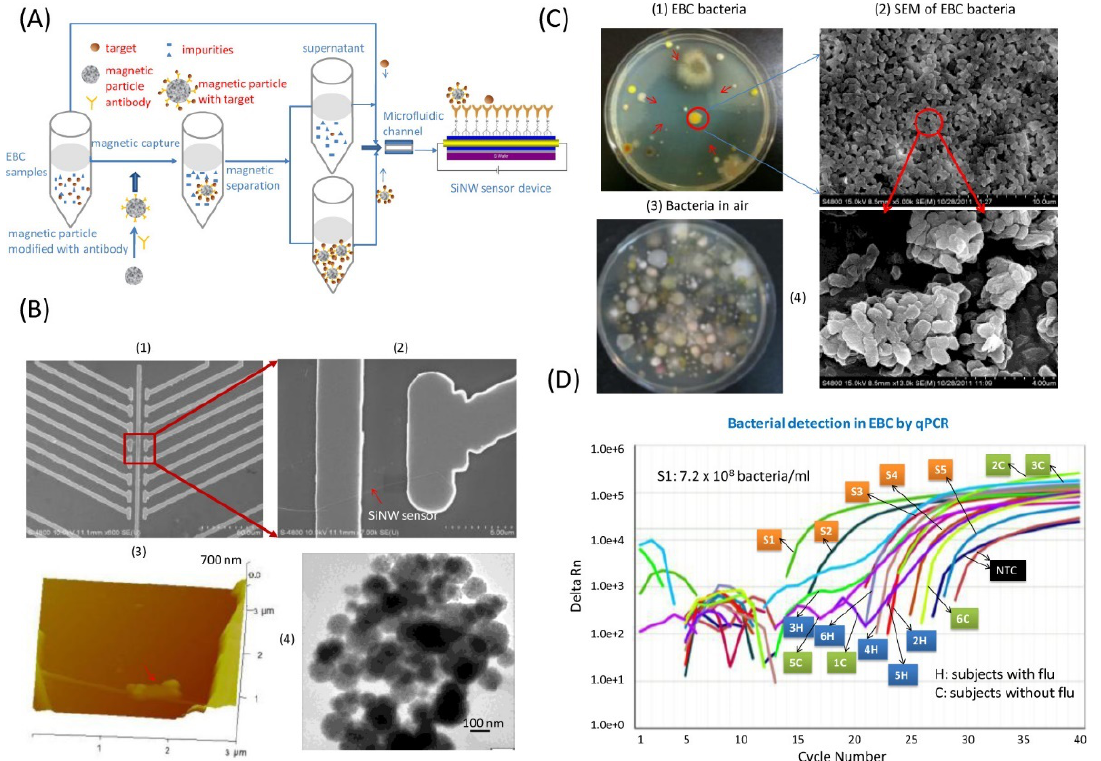
Figure 4. ( A ) Shows an experimental method for detecting Influenza virus and 8 iso Prostaglandin F2 α (PGF 2a) in exhaled breath condensate (EBC) samples using a silicon nanowire (SiNW) sensor device with and without magnetic concentration. The EBC samples were collected, diluted 100 times, and then flowed at a rate of 170 L/min to the sensor device. ( B ) SiNW sensor apparatus used in the sensing tests: (1) an optical image of the chip device; (2) a scanning electron microscopy (SEM) image of a single SiNW sensor; (3) an atomic force microscopy (AFM) image of a SiNW device modified with an anti-H3N2 virus antibody and infected with viruses; and (4) SEM photos of magnetic beads. ( C ) Bacteria found in indoor air and EBC samples taken from human participants with and without the flu (Influenza virus). Following culture, bacteria were found in the following samples: (1) EBC samples; (2) SEM images of the bacteria present in the samples; (3) indoor air samples; and (4) higher resolution SEM photographs of the bacteria present in the samples (2). ( D ) The use of quantitative PCR (qPCR) to identify bacteria in EBC samples obtained from flu patients and healthy individuals. Reproduced with permission from ref. [134]. Copyright 2012, American Chemical Society.